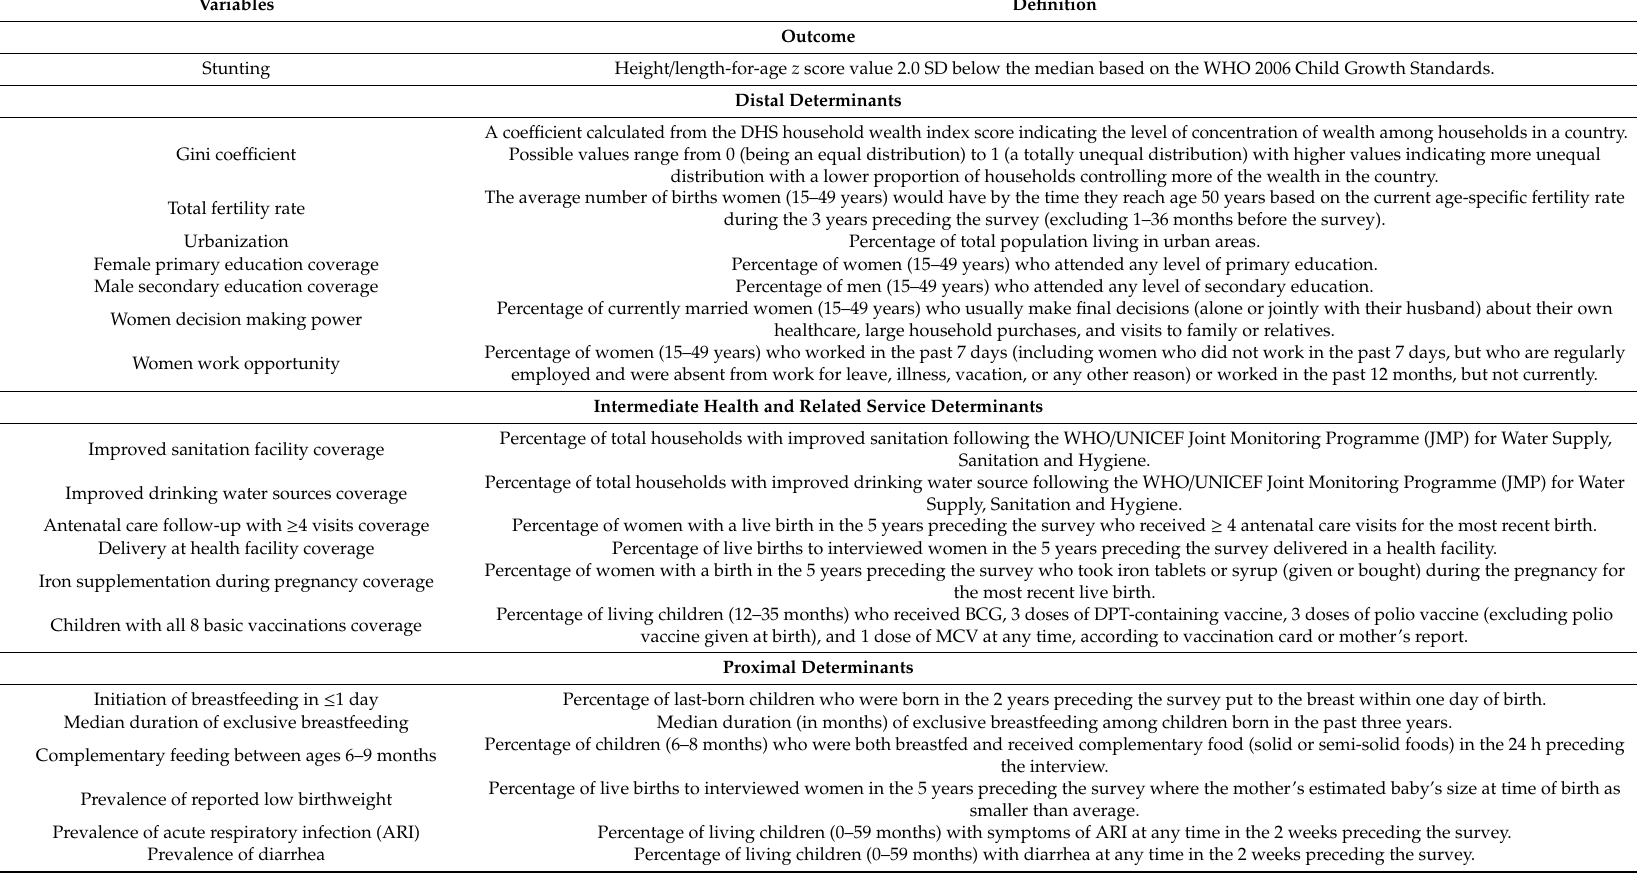
Table 1. Description of variables used in the study 1